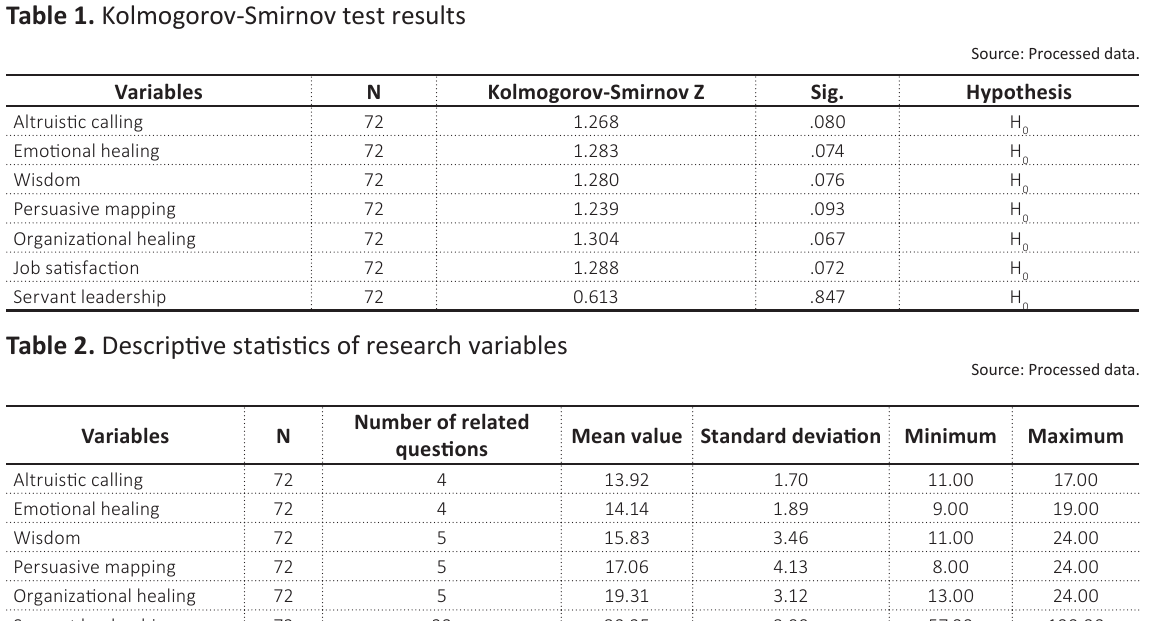
Table 1. Kolmogorov-Smirnov test results